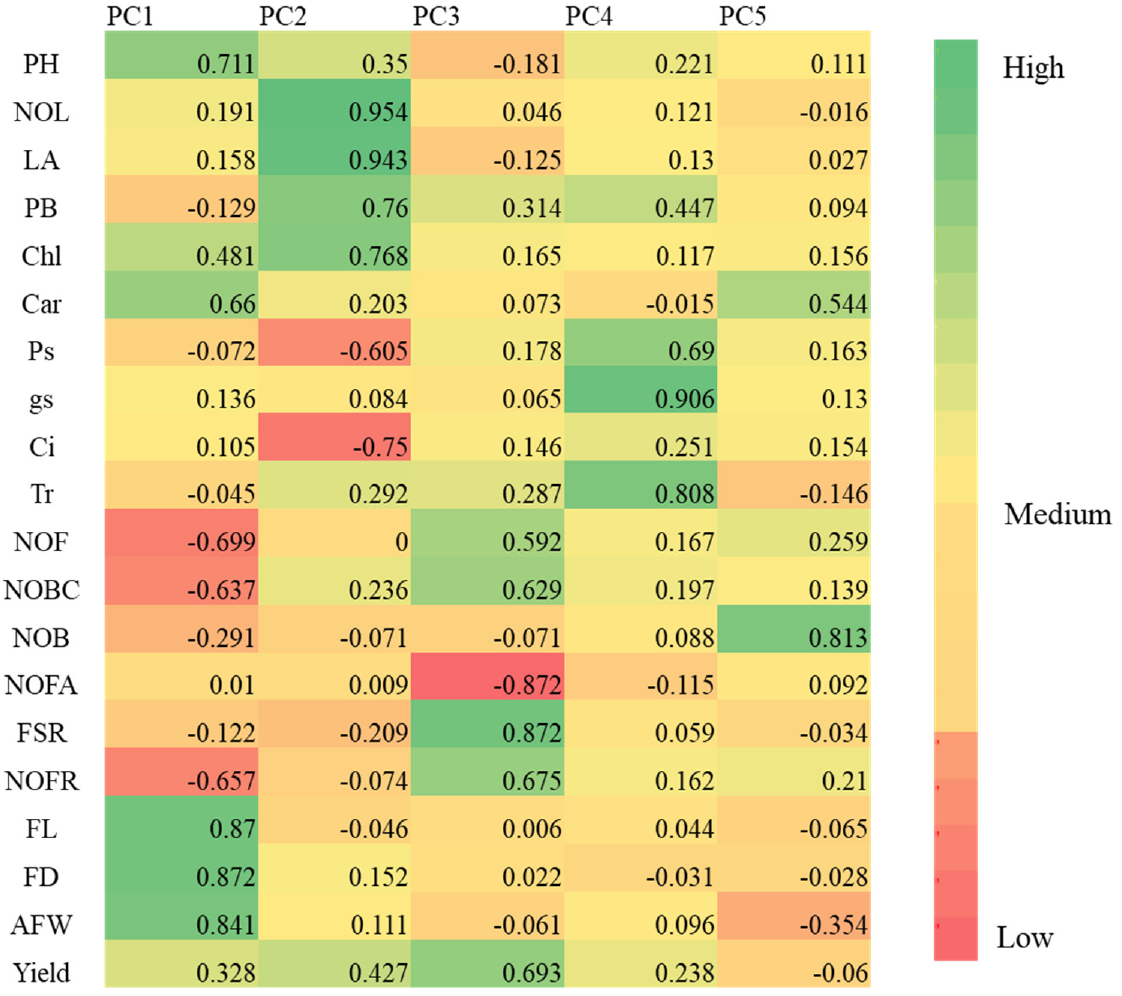
Figure 10. Heat map of five principal components (PCs) showing respective loadings of the parameters during the reproductive stage of the experiment. Abbreviations: AFW—average fruit weight; FSR—fruit setting ratio; NOL—number of leaves; LA—leaf area ratio; Chl—chlorophyll; Car—Carotenoid; NOF—number of flower; NOFR—number of fruits; NOB—number of bud cluster; NOBC—number of bud per cluster; NOFA—number of flower aborted; FL—fruit length; FD—fruit diameter; PH—plant height; PB—plant biomass; Ps—photosynthetic rate; gs—stomatal conductance; Ci—Internal CO 2 ; Tr—transpiration rate. Different shades of red, yellow and green represent lower, medium and higher values, respectively